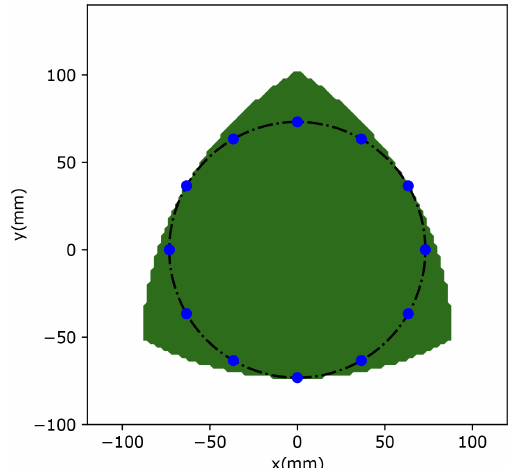
Figure 11. Workspace of the optimal PPM for l 0 = 200, l 1 = 100, and l 2 = 89mm.